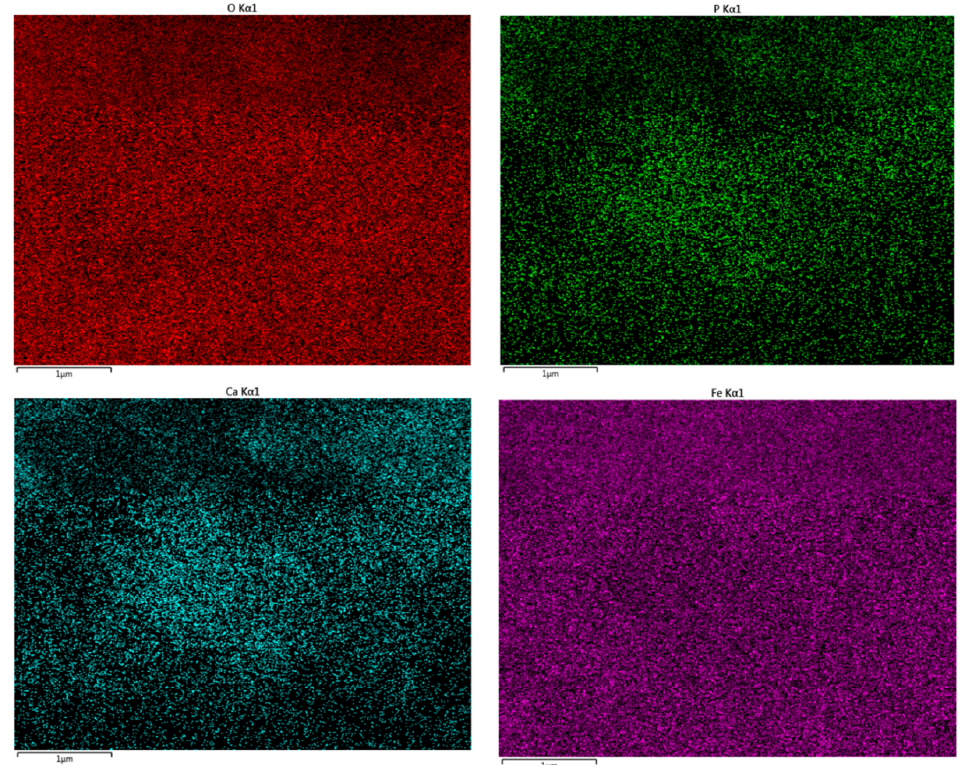
Figure A3. EDX-Mapping of the SPION HAp after drying dispersed nanoparticles on air. The Kα of carbon (yellow), oxygen